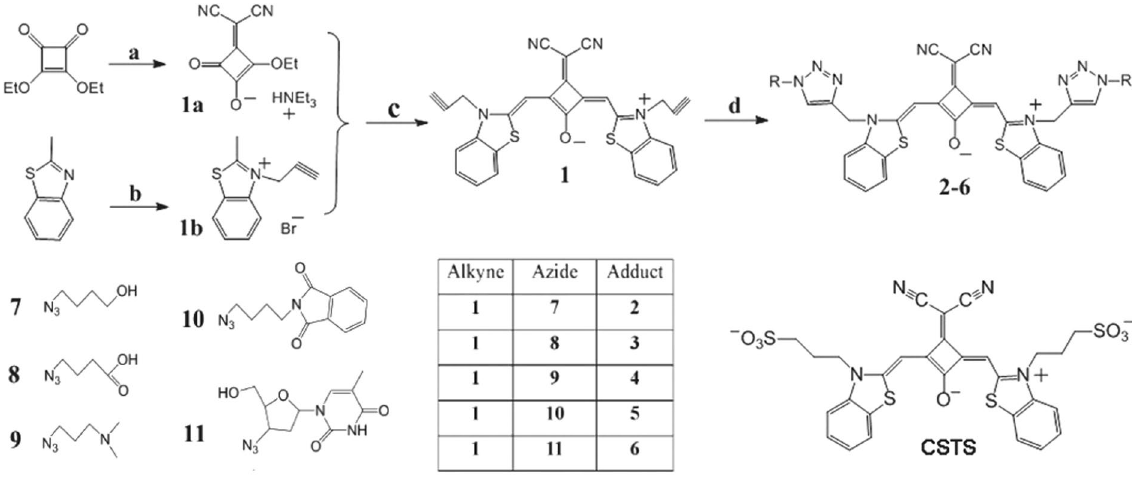
Figure 1. Synthetic route of compound 1–6 . Reagents and conditions: ( a ) malonodinitrile, triethylamine, benzene, room temperature, 30 min; ( b ) propargyl bromide, CH 3 CN, reflux, 8 h; ( c ) toluene, n-butanol, pyridine, reflux, 8 h; ( d ) sodium ascorbate, CuSO 4 ·5H 2 O, TBTA, DMSO/H 2 O (10:1), room temperature, 3